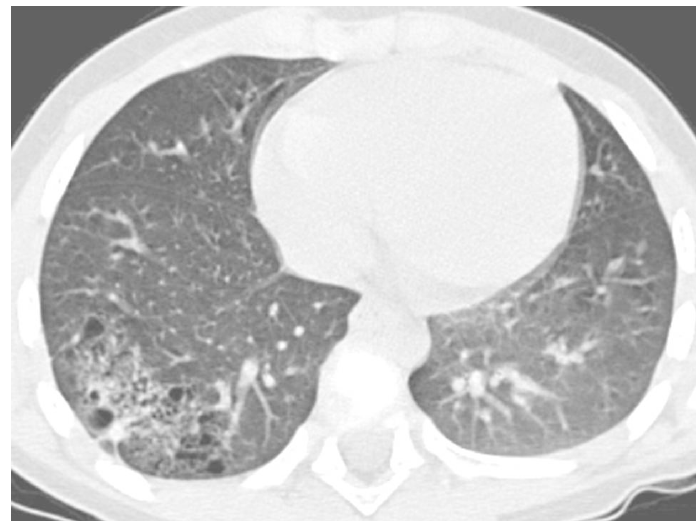
Figure 4. High resolution computed tomography scan of a 6-year-old boy with recurrent pneumonia in the right lower lobe due to congenital cystic adenomatoid malformation (diagnosis confirmed at lung biopsy after lobectomy).